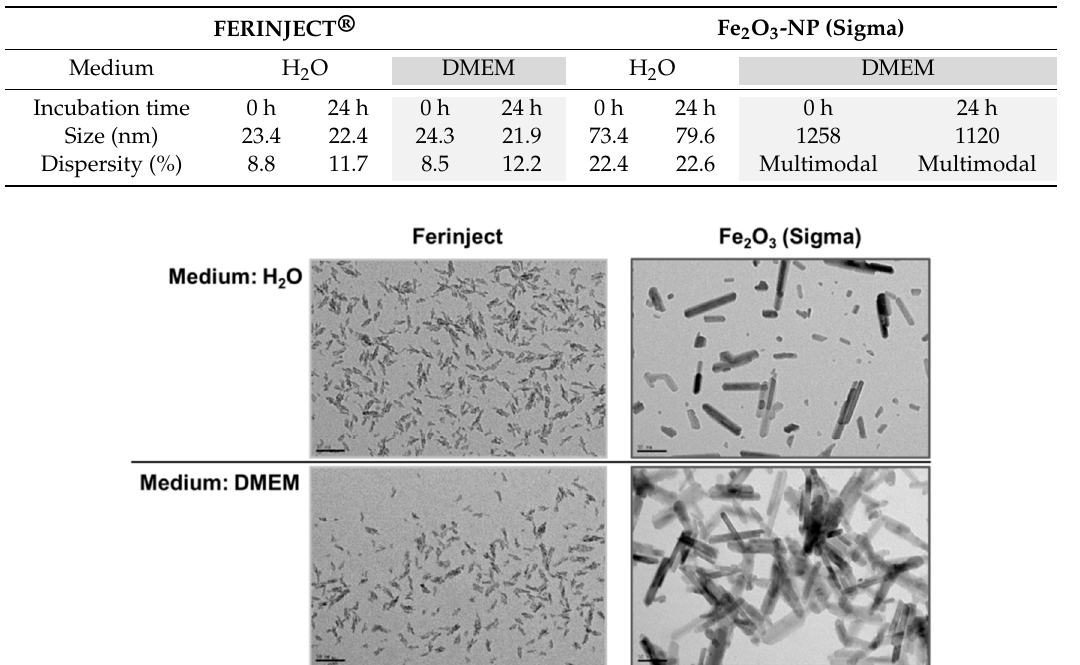
Figure 1. Characteristics of FERINJECT ® and Fe 2 O 3 -NP by TEM. Nanoparticles were incubated in H 2 O or DMEM (with carboxymaltose coating for Fe 2 O 3 -NP) after 24 h of incubation at 37 °C, 5% CO 2 . Scale bar 50 nm.